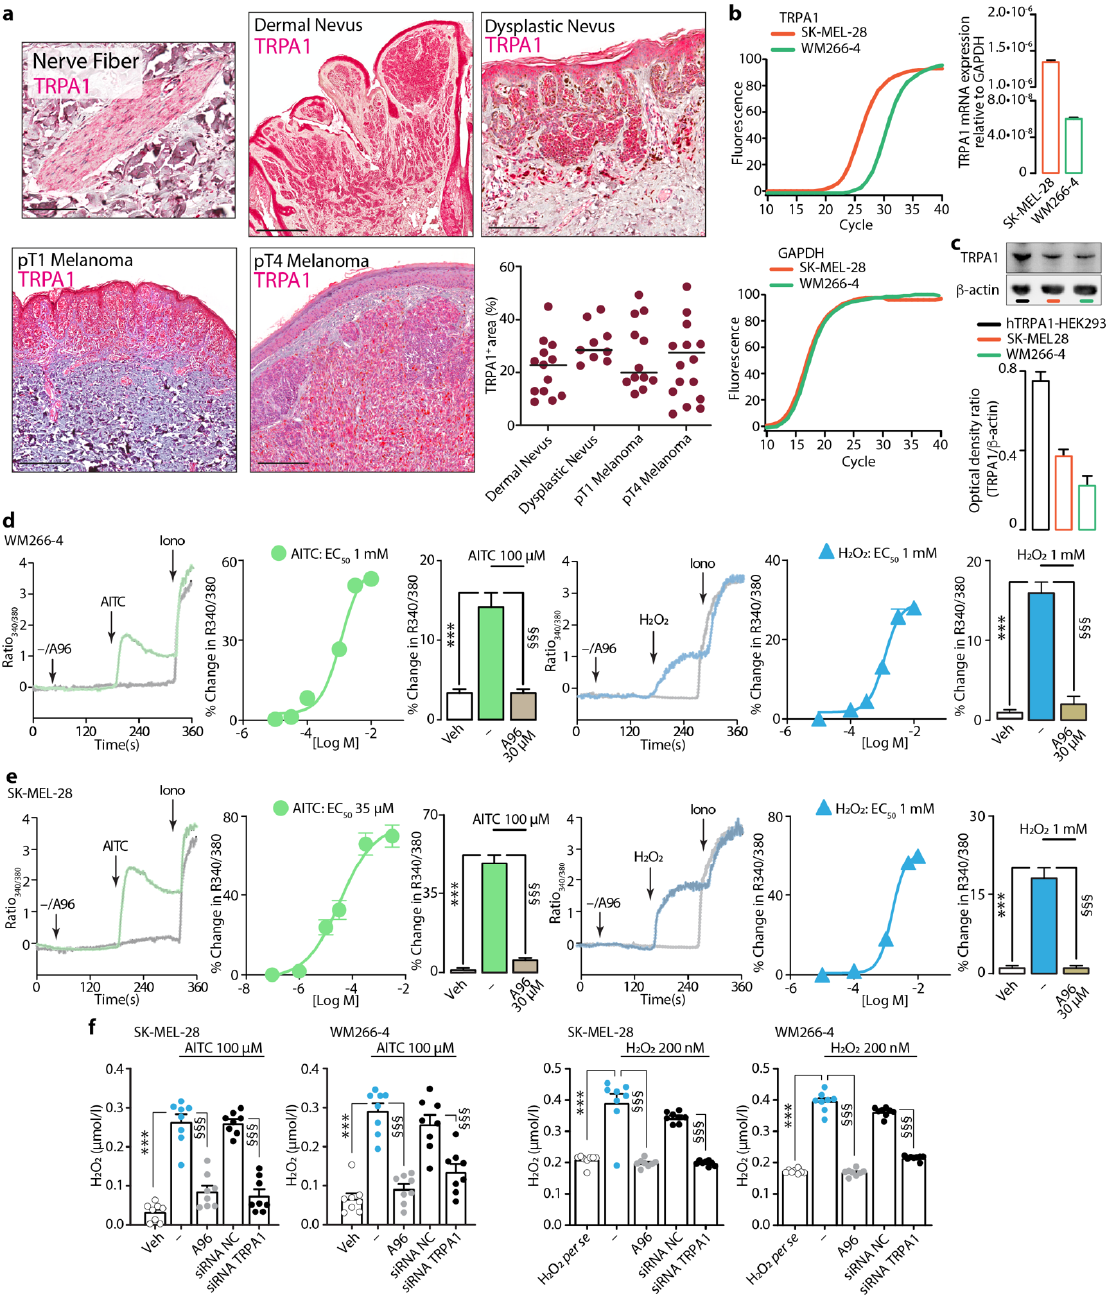
Figure 3. TRPA1 expression and function in dermal and dysplastic nevi and melanoma tissues and melanoma cell lines. ( a ) Representative images of TRPA1 staining in cutaneous nerve fiber (scale bar 50 μ m) and representative images and cumulative data of the automatic staining area quantification in dermal and dysplastic nevus, and pT1 and pT4 melanoma tissues (scale bar 500 μ m). ( b ) Representative curve and cumulative data of TRPA1 mRNA relative expression in WM266-4 and SK-MEL-28 cell lines. ( c ) Representative image of western immunoblot and TRPA1 protein content in cultured hTRPA1-HEK293, SK-MEL-28 and WM266-4 cell lines. Typical traces, concentration-response curve and pooled data of the calcium response evoked by AITC and H 2 O 2 in the presence of the TRPA1 antagonist, A967079 (A96) or its vehicle in WM-266-4 ( d ) and SK-MEL-28 ( e ) melanoma cells. ( f ) H 2 O 2 release from WM-266-4 and SK-MEL-28 melanoma cells induced by AITC or H 2 O 2 in presence of A96 (30 µ M) or its vehicle and after Trpa1 siRNA silencing or siRNA negative control (NC). Iono represents ionomycin; H 2 O 2 per se represents the value of H 2 O 2 not in presence of cells. Veh is the vehicle of AITC or H 2 O 2 , hyphen (-) is the vehicle of A96. *** p < 0.001, §§§ p < 0.001 one-way ANOVA and Bonferroni post hoc